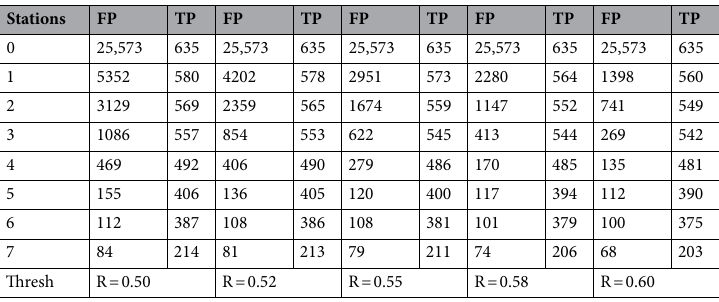
Table 1. True and False Positives (TP and FP) for various thresholds of the R value and number of stations flagging an